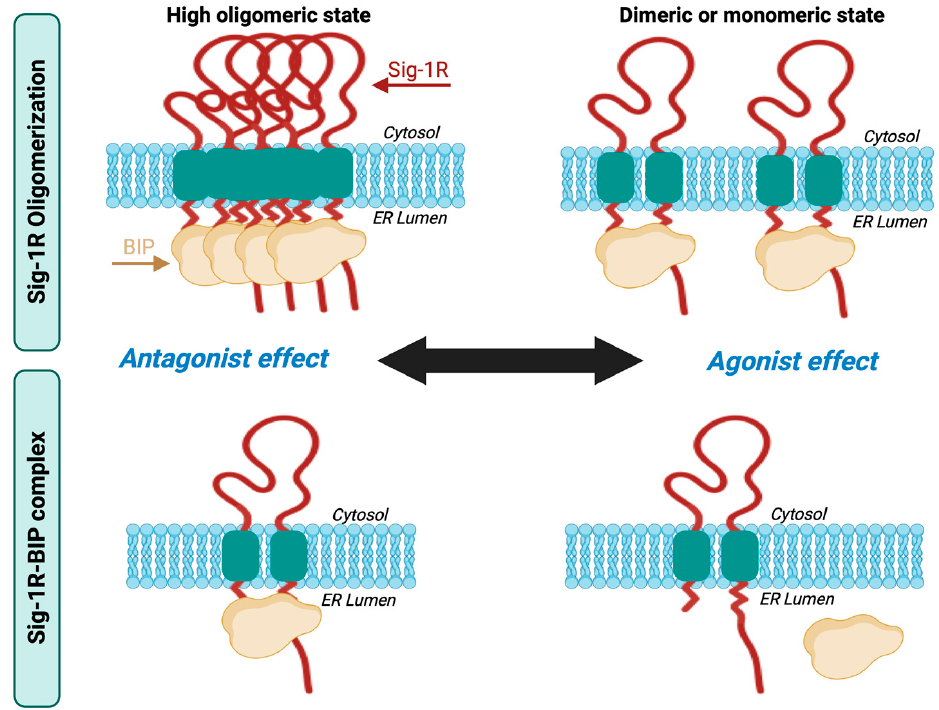
Figure 2. Sig-1R oligomerization and Sig-1R-BiP complex formation. Sig-1R ligands fine-tune their fluctuating oligomeric states in which antagonists promote the stabilization of the Sig-1R-BiP complex, and agonists favor Sig-1R dissociation from BiP.